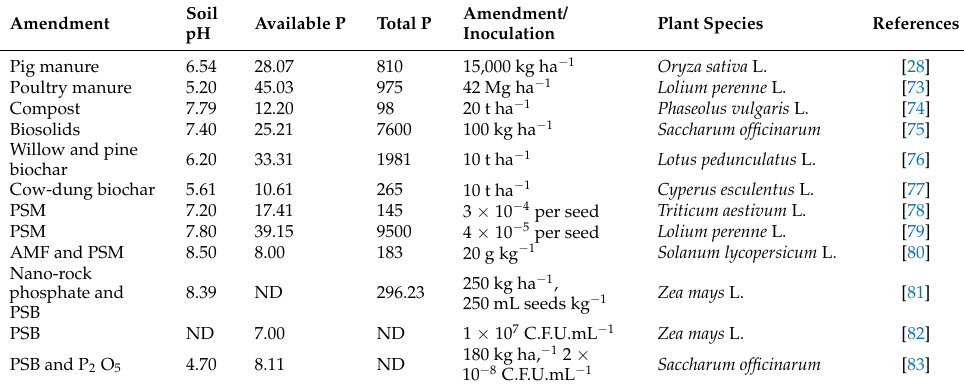
Table 2. Different amendment/inoculation methods used and concentrations of available and total P (mg kg − 1 ) in agricultural